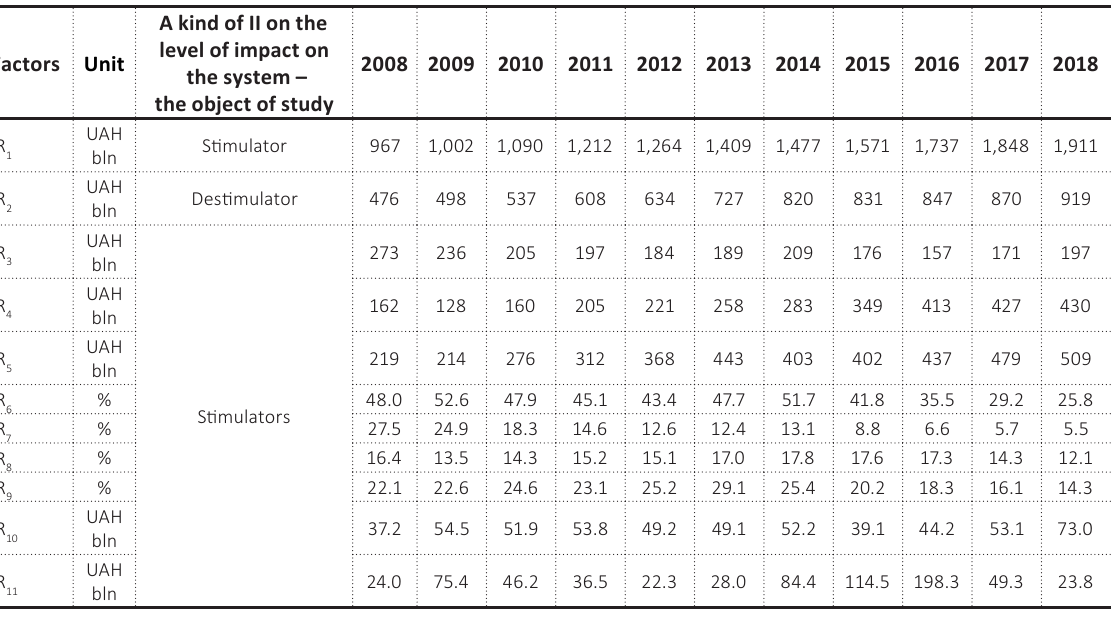
Table B1. Performance system of the “Financial results” component Source: Compiled according to the data of the National Bank of Ukraine.